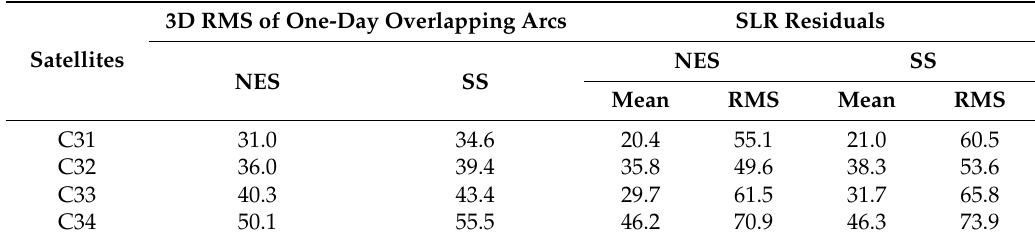
Table 6. BDS-3 orbit accuracy of the two methods based on one-year observations (cm).